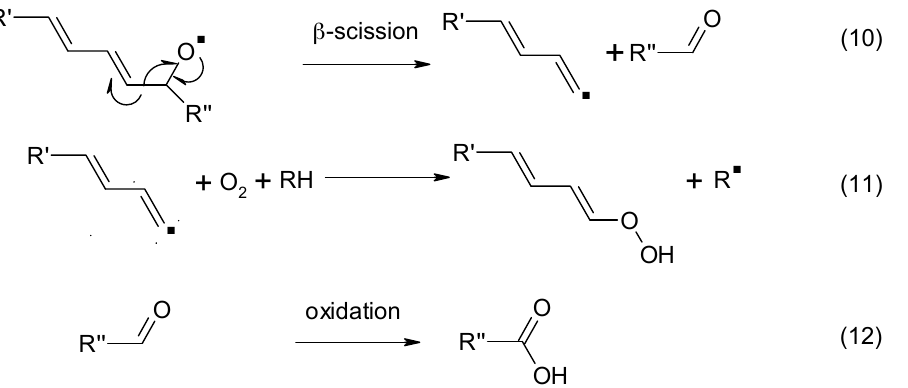
Scheme 3. Example of β -scission reactions of fatty-acid derived alkoxy radical leading to aldehydes and acids and acids [4].